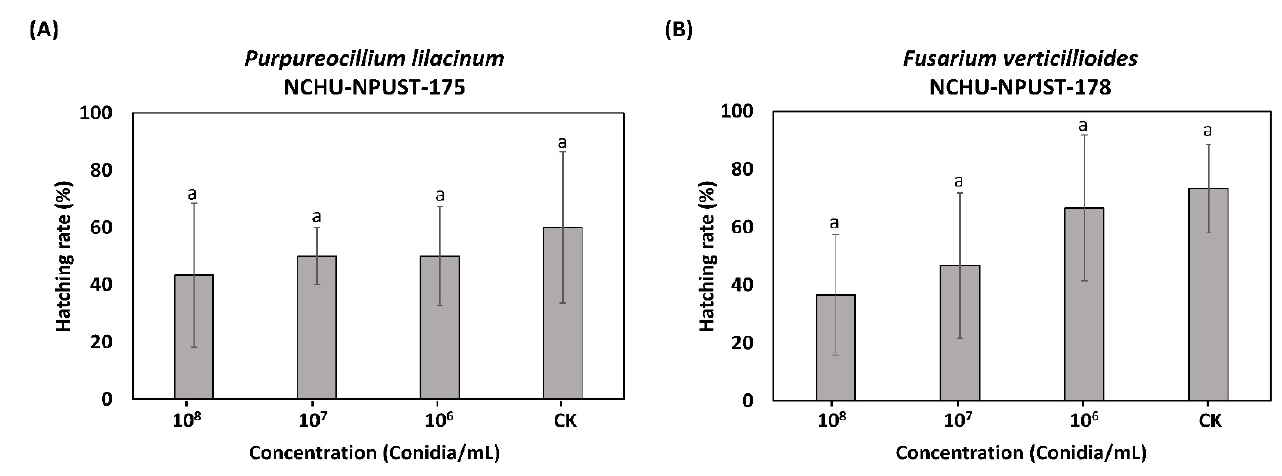
Figure 4. Hatching rate of F. taiwana eggs at 7 d.p.i. of ( A ) P. lilacinum PL-NCHU-NPUST-175 and ( B ) F. verticillioides FV-NCHU-NPUST-178. The same letters mean no significant difference ( p > 0.05) based on Tukey’s test.